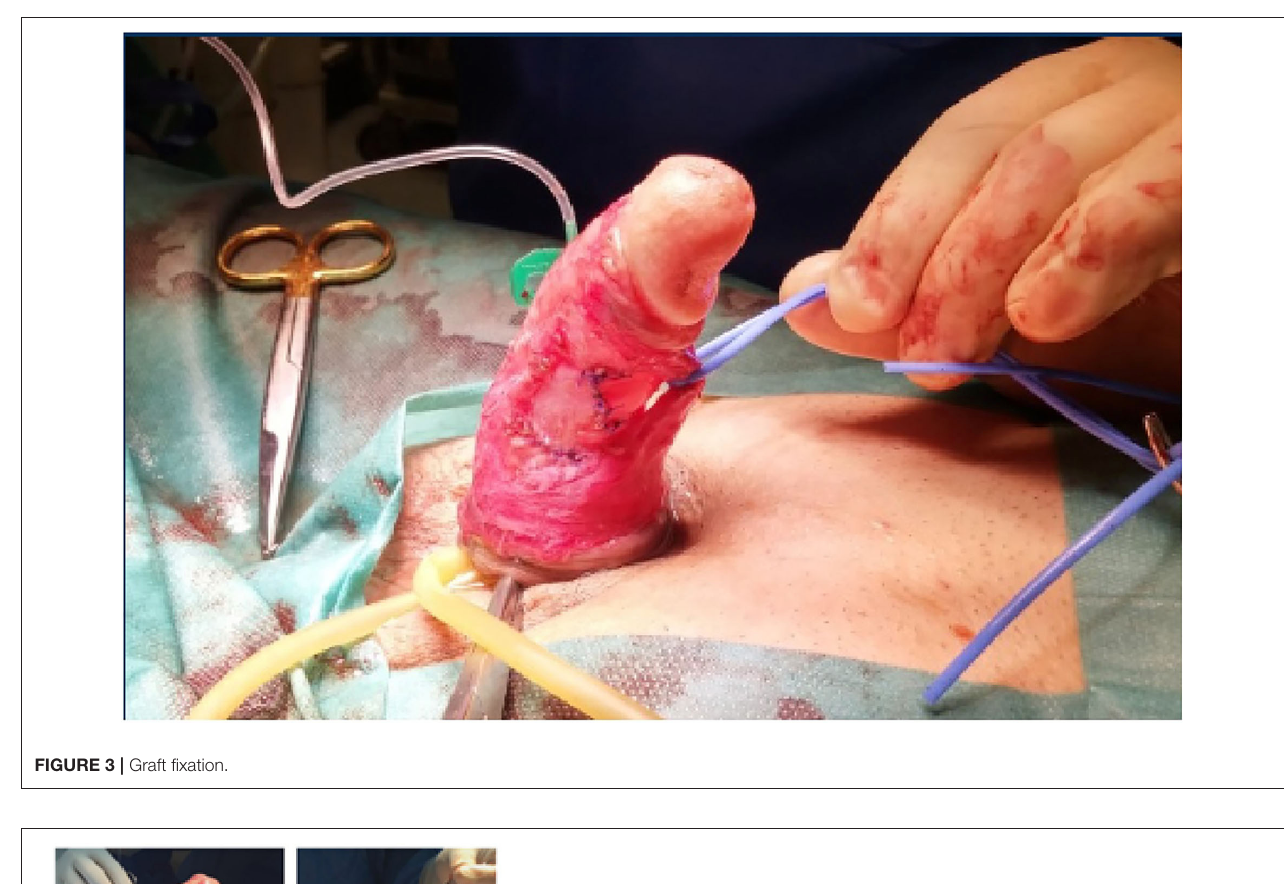
FIGURE 3 | Graft fixation.